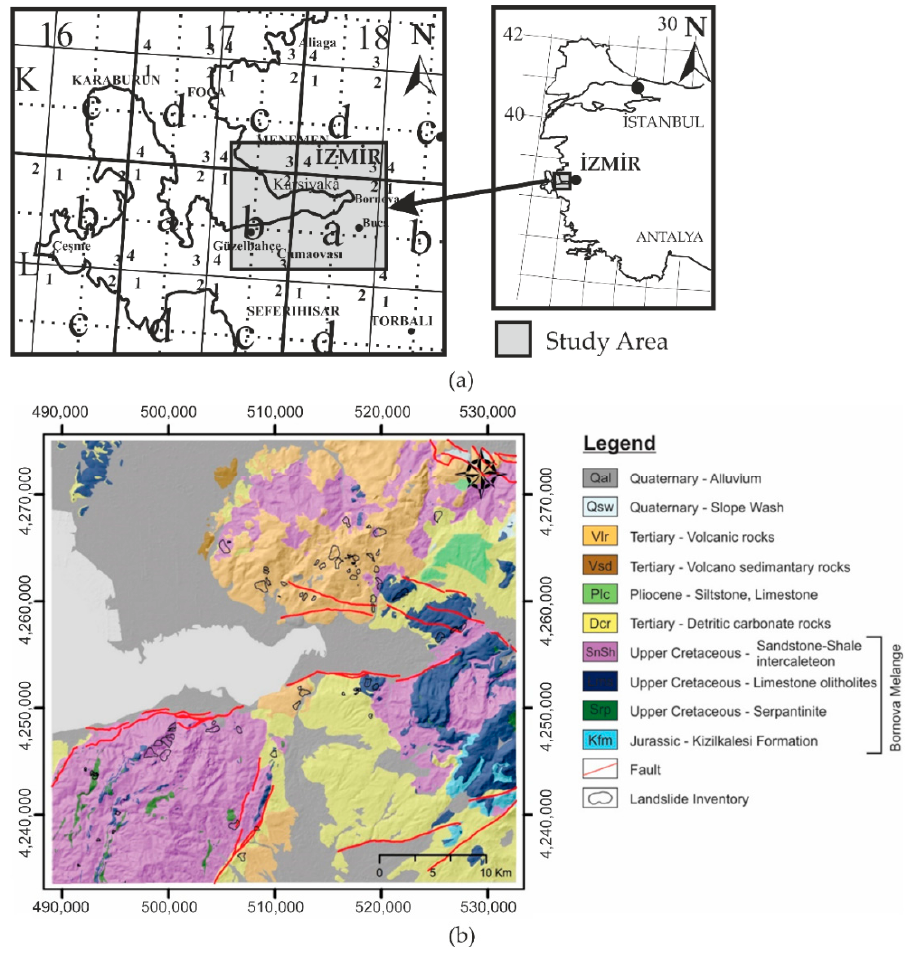
Figure 1. ( a ) Location map, ( b ) Geological map of the study area [75]. Bornova m é lange is represented by intercalations of sandstone–shale and the Kizil- kalesi formation that occurs in that matrix includes serpentinite blocks and limestone olistoliths (Figure 1b). Lower Miocene–early Pliocene Neogene sedimentary rocks